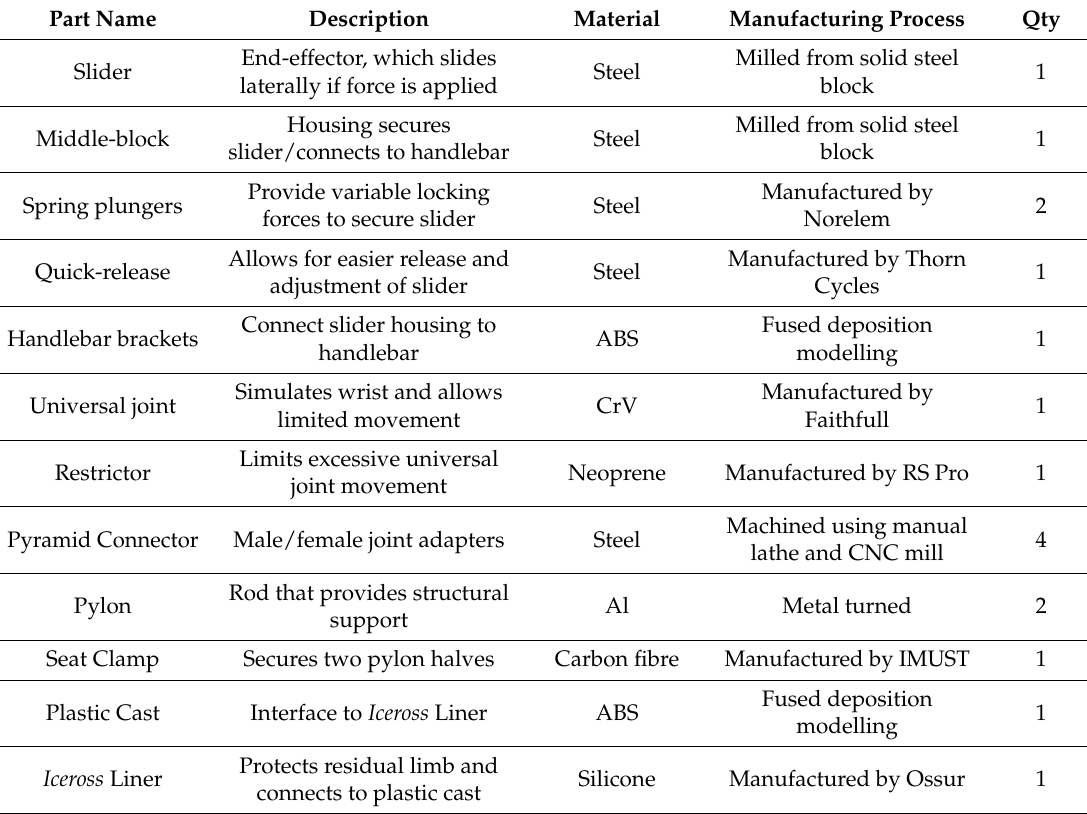
Figure 8. Manufactured upper-limb cycling prosthesis. Table 2. Manufacturing details for upper-limb cycling